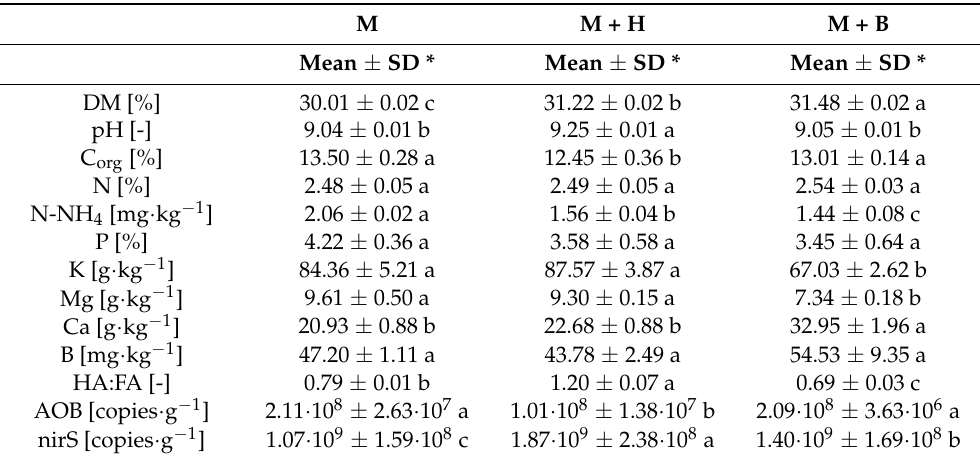
Table 3. Properties of the maturated manure variants (mean ± standard deviation, n = 3, * statistically significant difference at p ≤